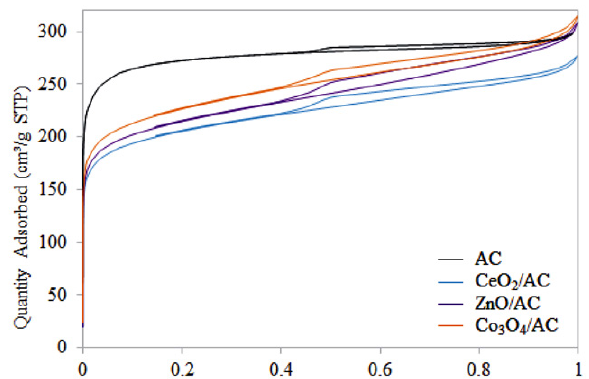
Figure 2. N 2 adsorption-desorption isotherms of the adsorbents.